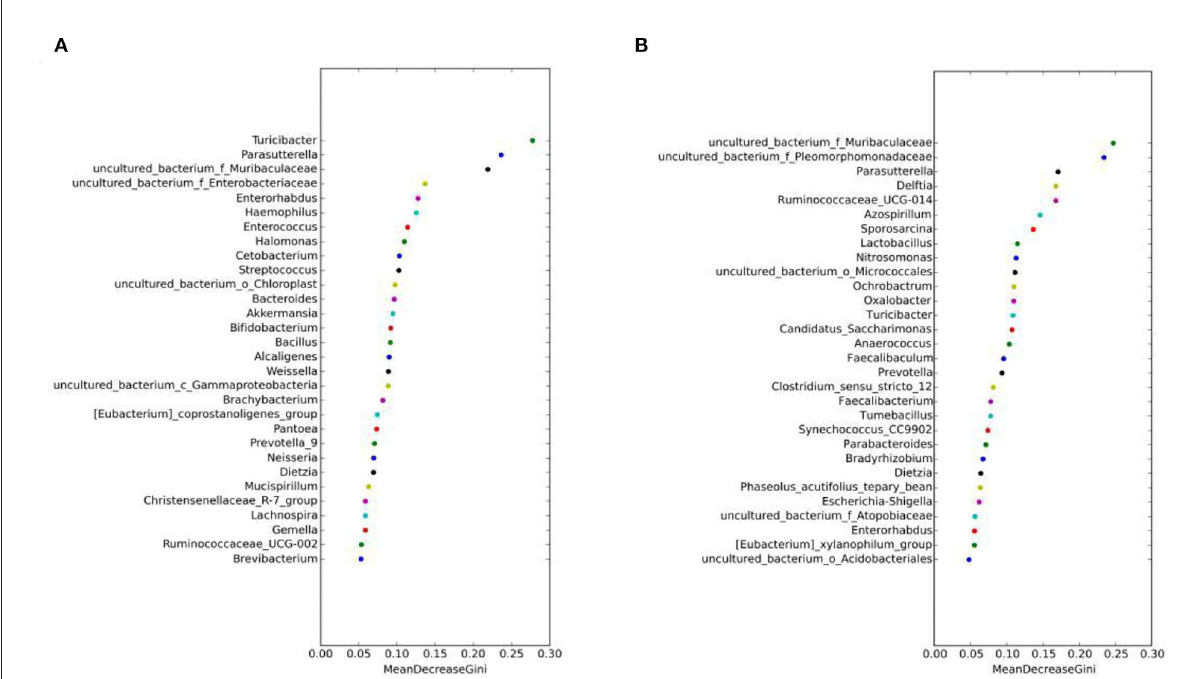
FIGURE7 Random forest algorithm analysis of MAM (A) and intestinal LM (B) . The horizontal axis is the mean decrease Gini, and the vertical axis is the top 30 genera with the highest relative abundance. The larger the mean decrease Gini, the higher the contribution of bacteria.